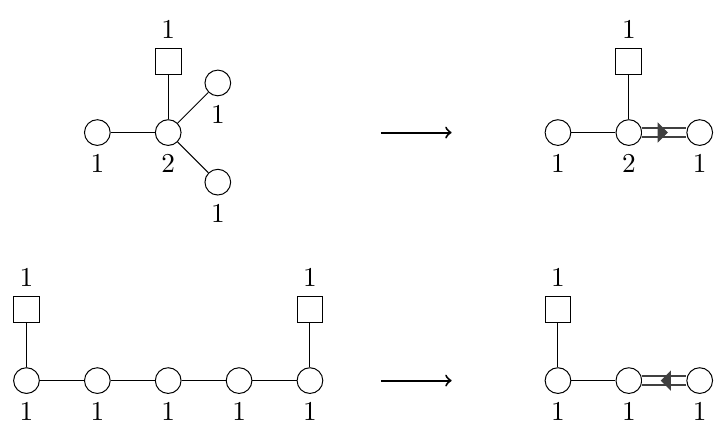
Figure 7 . Quivers on the left fold into quivers on the